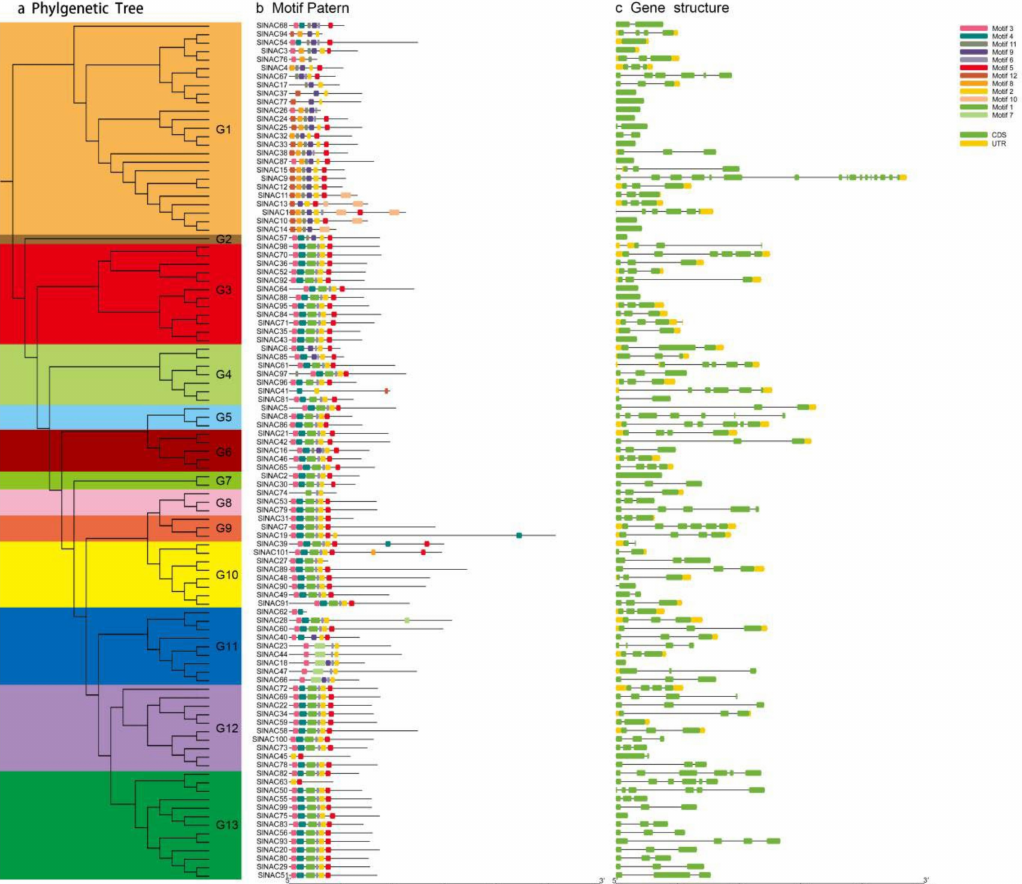
Figure 2. Phylogenetic tree, conserved motifs, and gene structures of the SlNAC genes. ( a ) Phyloge- netic tree constructed using MEGA software version 5.05 with 1000 bootstrap replicates based on 101 SlNAC protein full-length sequences (G1–G13 indicate 13 clades). ( b ) The motif compositions of the SlNACs were identified using the Multiple Expectation Maximization for Motif Elicitation (MEME) program. A total of 12 motifs were predicted and the different motifs are indicated in different colors. ( c ) The gene structures of the SlNACs were visualized using TBtools software version 1.098769. The green boxes represent CDs, the yellow boxes represent UTR, and the black lines represent